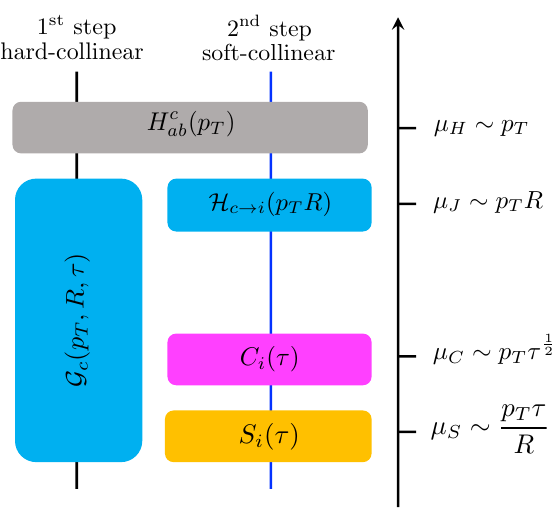
Figure 1 . Illustration of the two-step factorization procedure for the ungroomed jet mass distribu- tion. The (cid:12)rst step is a hard collinear factorization of the siJMFs The second step is a soft collinear factorization of collinear functions C i , and collinear-soft functions S i